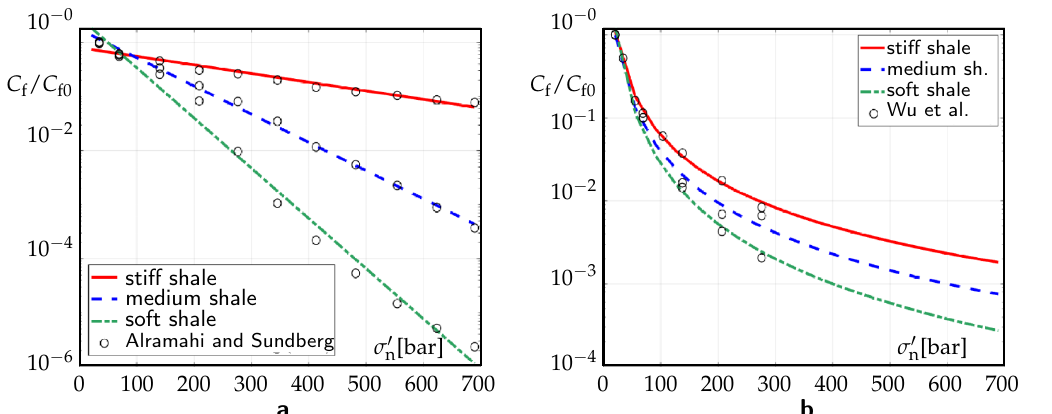
Figure 7. Normalized fracture conductivity C f / C f0 plotted against the effective normal stress σ (cid:48) n on a fracture for ( a ) propped fractures and ( b ) unpropped